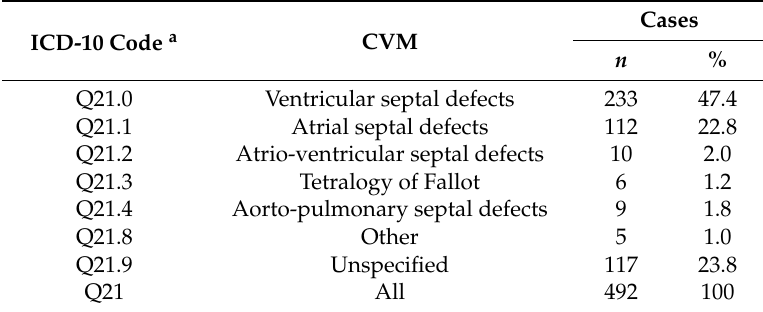
Table 2. Distribution of septal heart defects (SHDs) for the combined data set of newborns registered in the MCBR and the MRCDR during the period